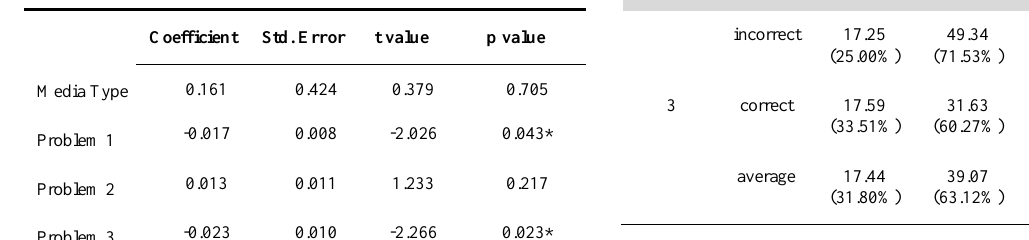
Logistic regression results showing relationship between students’ scores and total fixation duration in each problem as well as media type.